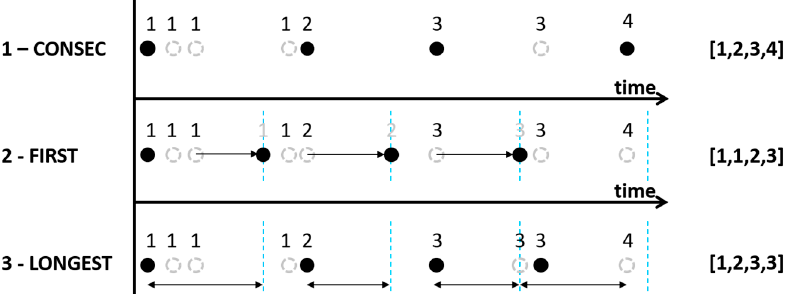
Figure 3. Methods to filter the raw cell sequences, where dashed open cells are all points in the GPS trace, the closed cells are the cells selected according to each method, and the resulting raw cell sequences are identified as [x,x,x,x].